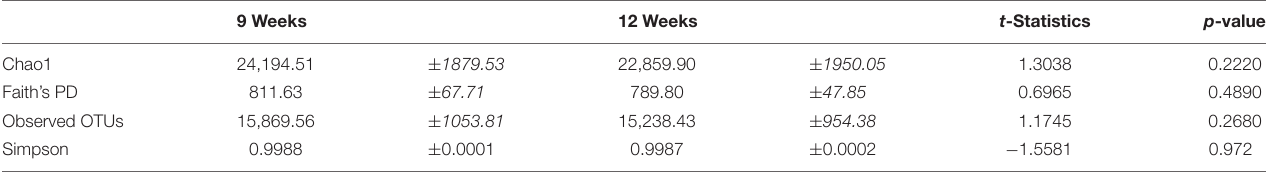
TABLE 1 | Alpha diversity metrics at cabbage growth stages [week 9 and 12 (no aphids) harvest] using a non-parametric two-sample t -test using Monte Carlo permutations [Mean ( ± SD )].